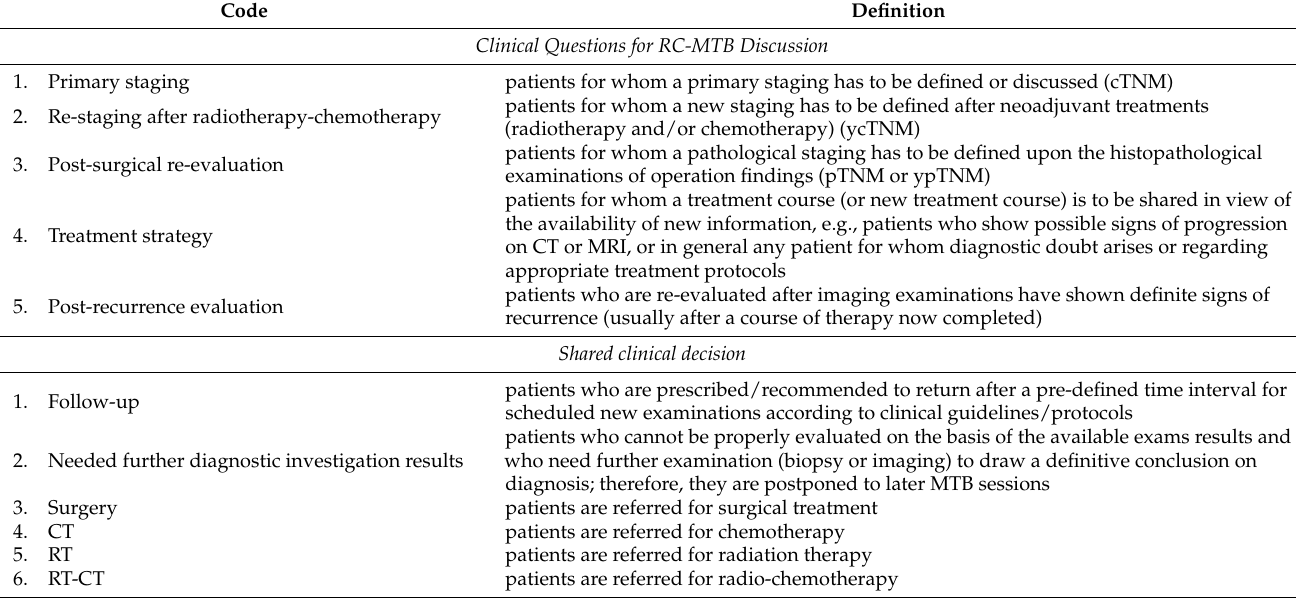
Table 1. Clinical questions for RC-MTB discussion and shared clinical